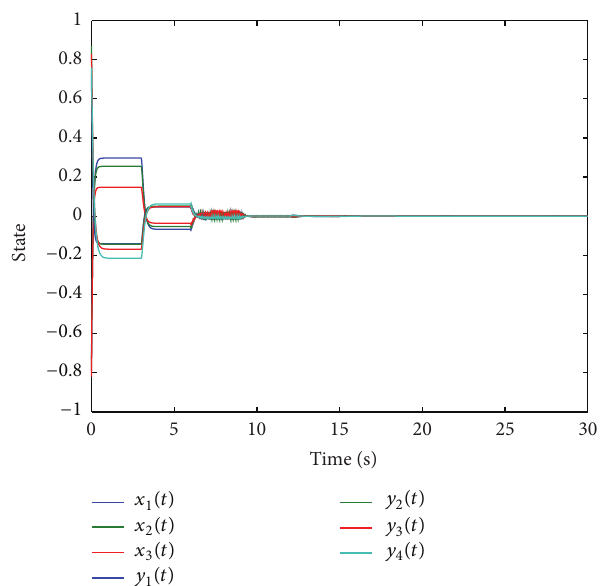
Figure 8: Simulation of the system (77) under the sliding intermit- tent